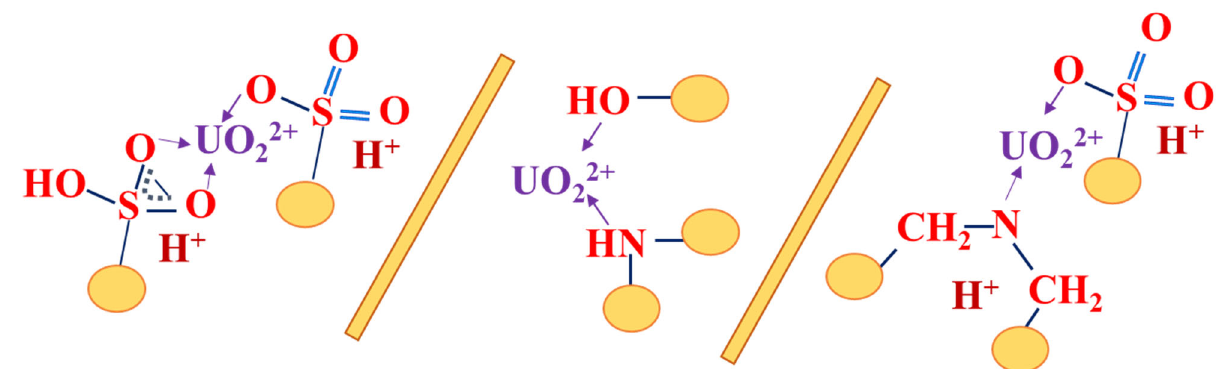
Figure 9. suggest binding mechanism of functionalized sorbent toward U(VI) ions. Figure 9. Suggest binding mechanism of functionalized sorbent toward U(VI)